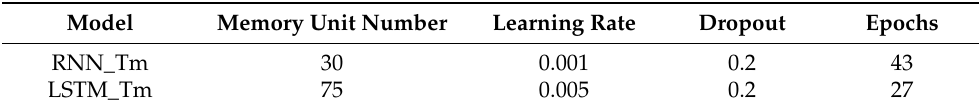
Table 1. Optimal hyperparameters of the two models.